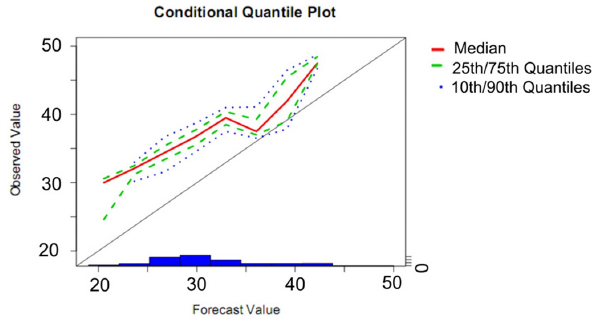
Fig. 3. Conditional Quantile Plot (CQP) diagram for MM5 2-m temperature